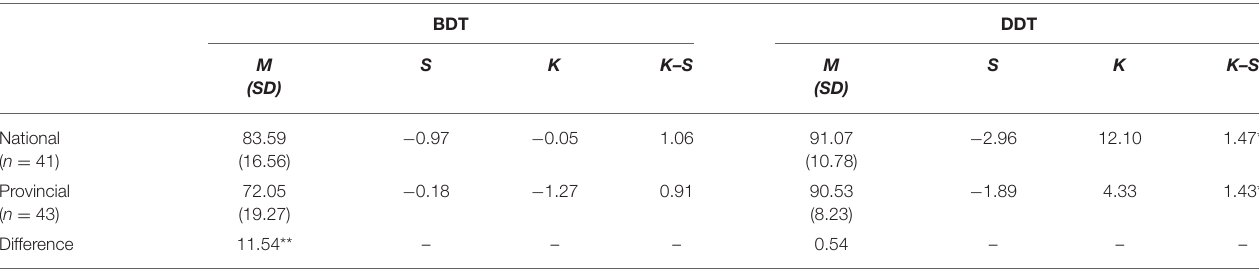
TABLE 1 | Accuracy (%) in BDT and DDT between the